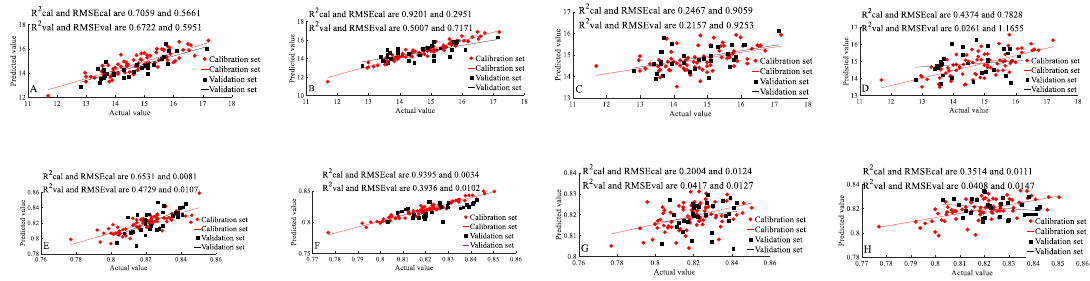
Figure 5. TSSC and water content detection after SG + GA processing. ( A , E ) VIS/NIR, ( B , F ) NIR, ( C , G ) machine vision, ( D , H ) E-nose, ( A – D ) TSSC detection, ( E – H ) water content detection.